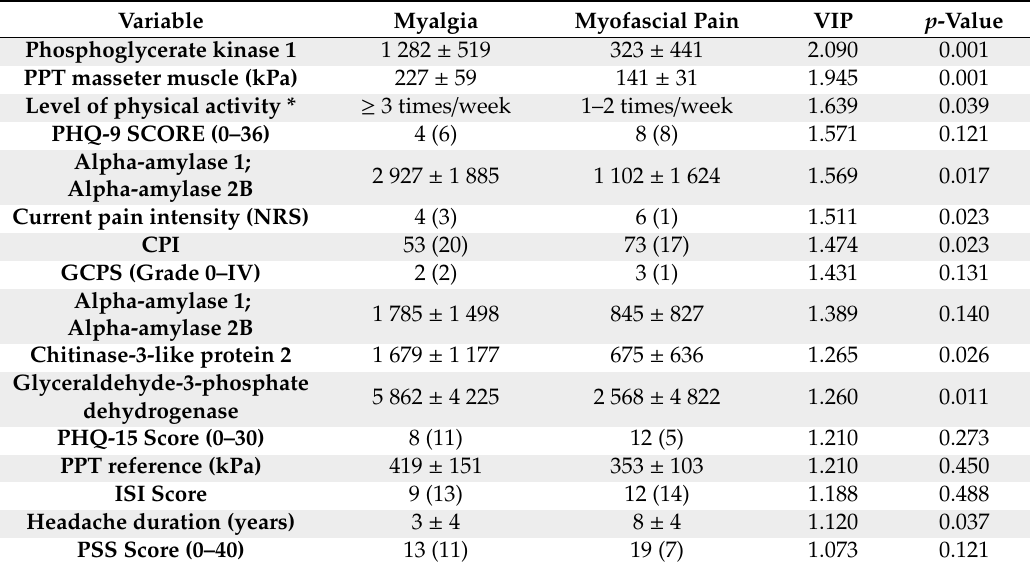
Table 3. Subclasses of temporomandibular disorders. Di ff erences between patients diagnosed with myalgia ( n = 10) and patients diagnosed with myofascial pain with or without referral ( n = 10) according to the Diagnostic criteria for temporomandibular disorders. Orthogonal projections to latent structure model characteristics: R 2 = 0.7, Q 2 = 0.4, CV-ANOVA = 0.01. Variables with VIP above 1.0 in the orthogonal partial least-squares discriminant analysis model are shown in decreasing order of VIP values. The p -value is according to the Mann–Whitney data